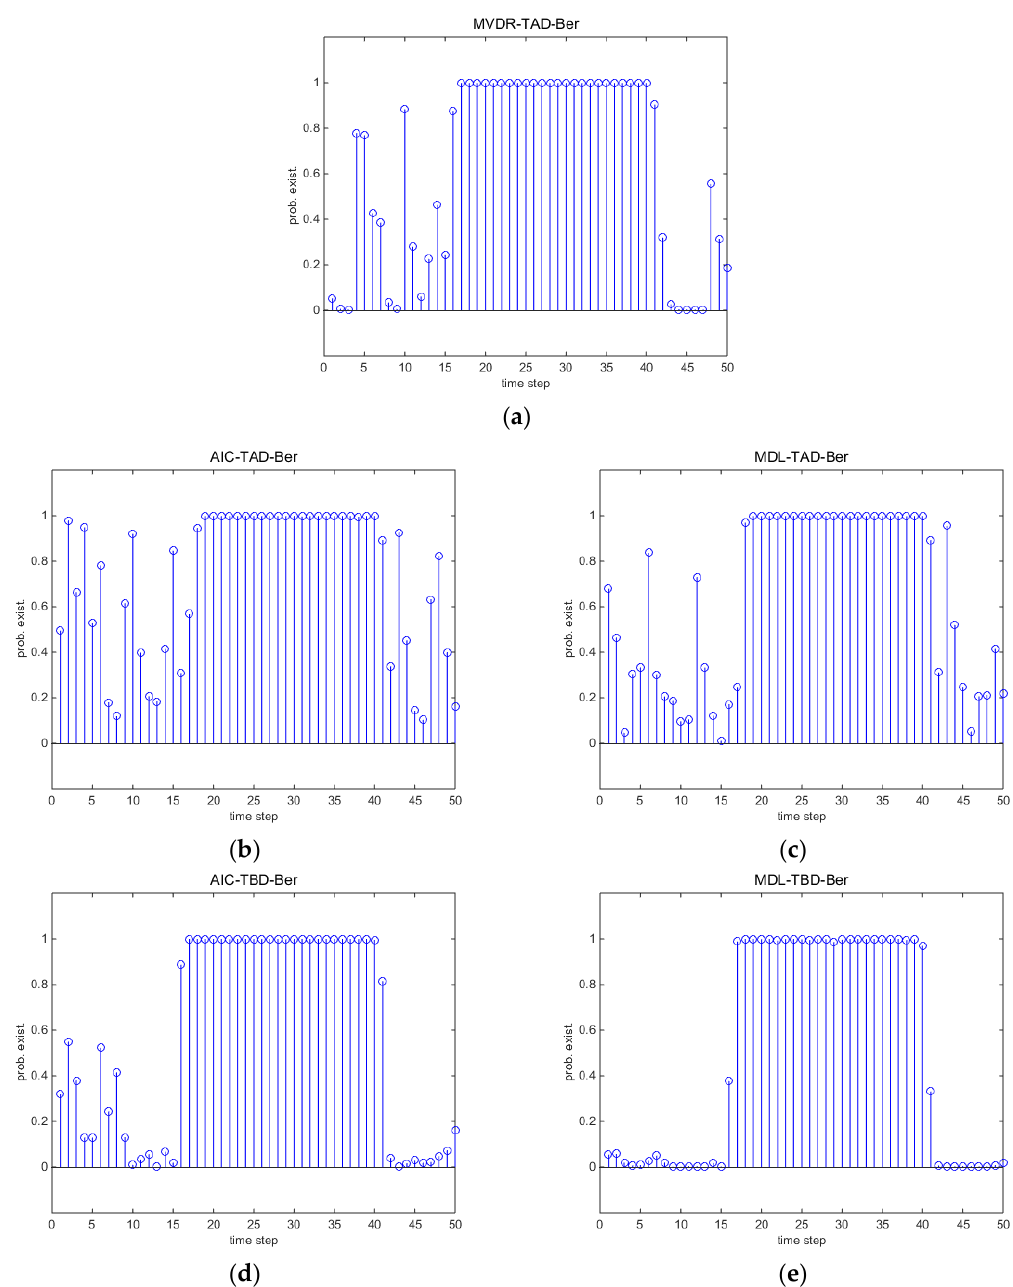
Figure 2. Direction-of-arrival (DOA) tracking results with signal to noise ratio (SNR) = −8 dB and snapshots 𝑁 = 50 . ( a ) minimum-variance-distortionless-response (MVDR)-TAD-Ber; ( b ) AIC-track- after-detect (TAD)-Ber; ( c ) MDL-TAD-Ber; ( d ) AIC-TBD-Ber; ( e ) MDL-TBD-Ber.